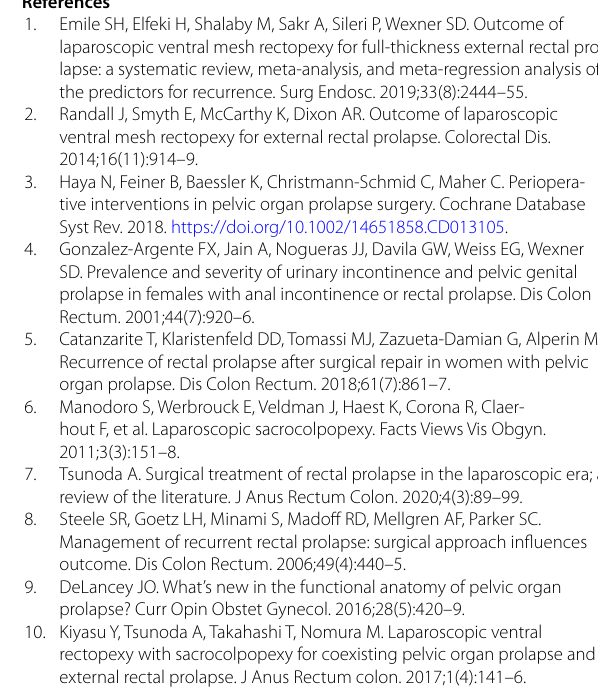
Fig. 5 Computed tomography (CT) scan shows no evidence of recurrent rectal prolapse one year later after